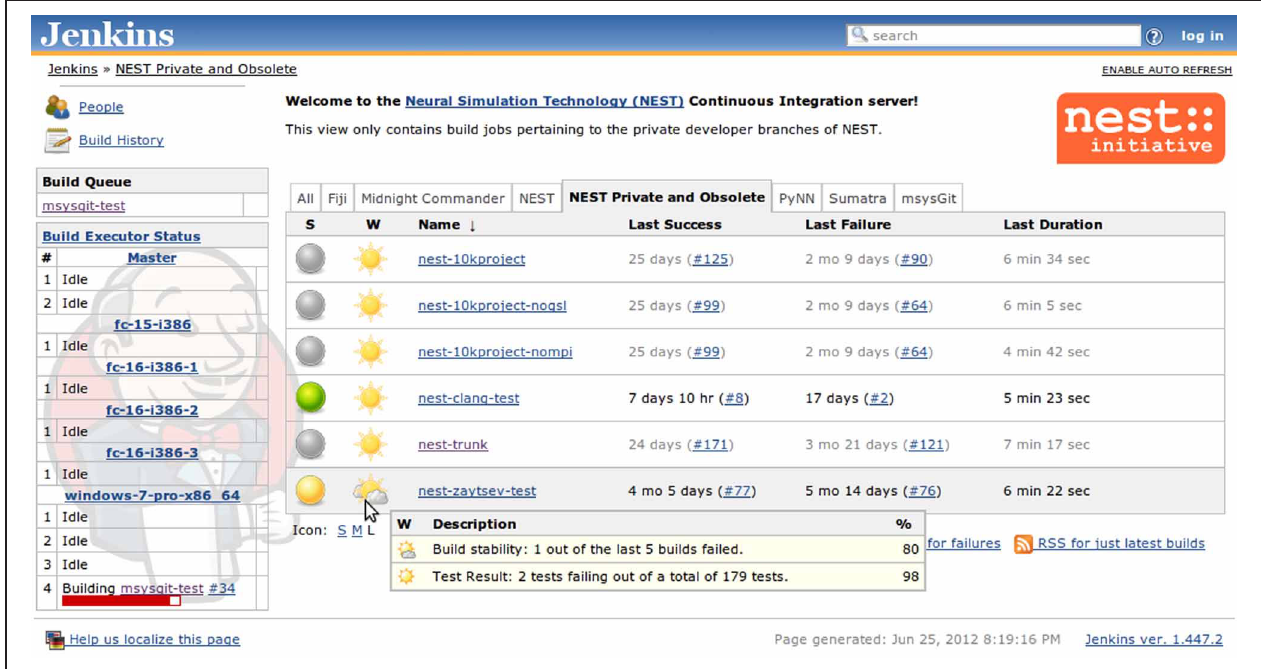
FIGURE 3 | Jenkins build job summary that aggregates information about the jobs registered with a particular view. The table in the middle shows for each job the build status (green balls for successful and stable builds, yellow for unstable builds, red for failed builds [not shown], and gray for disabled jobs), a weather report that includes